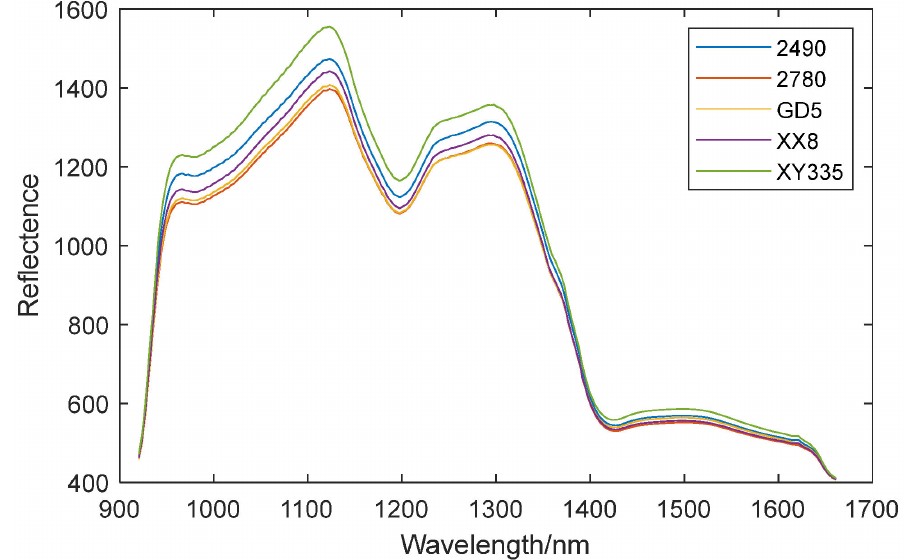
Figure 3. Average spectra of five kinds of corn